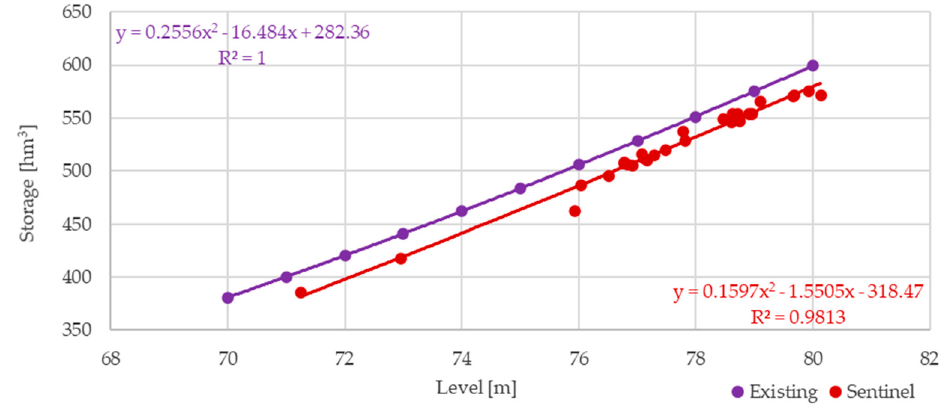
Figure 13. Estimated level and observed storage relationship compared to an existing relationship [42].